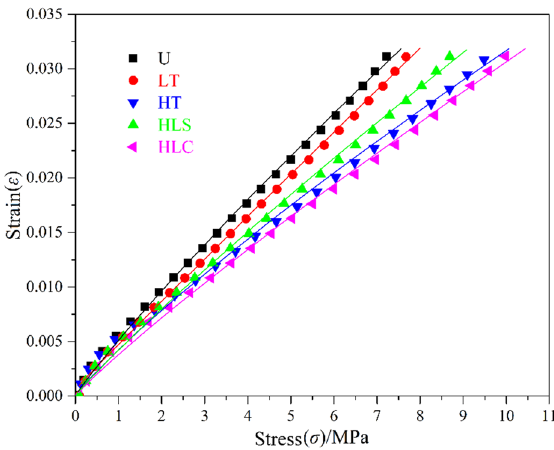
Figure 6. Stress–strain curves of HNIW/FOX-based PBX columns.